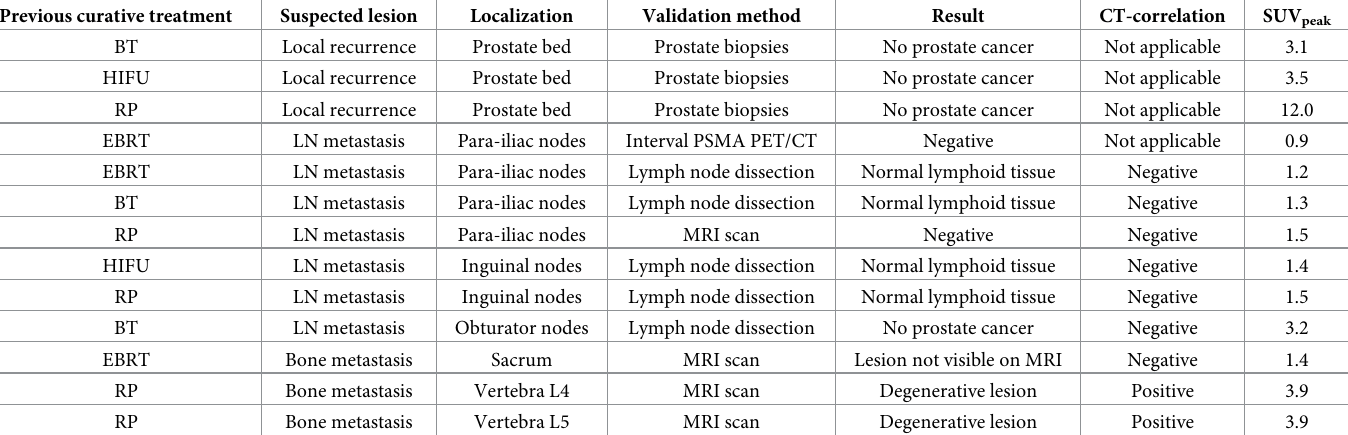
CT = computed tomography; SUV = standardized uptake value; LN = lymph node; MRI = magnetic resonance imaging; PSMA = prostate-specific membrane antigen; PET = positron emission tomography.